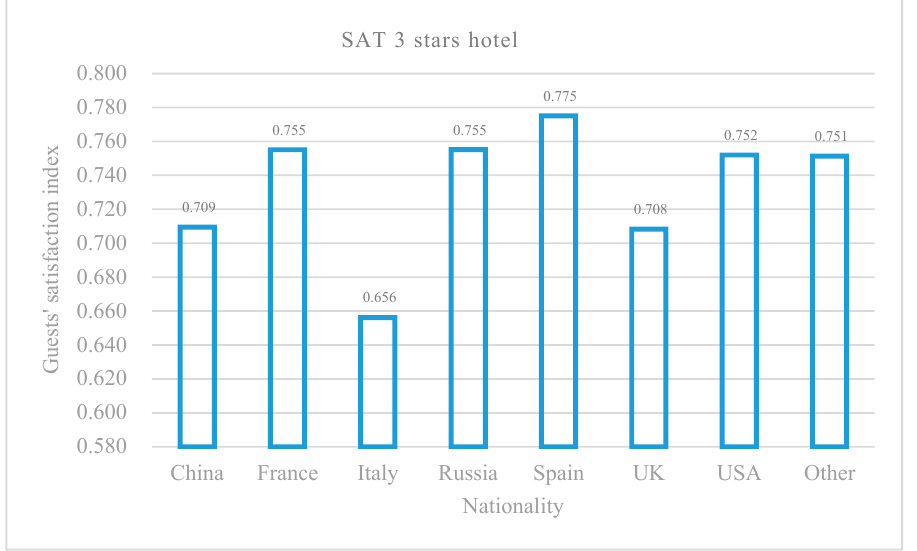
Figure 1. Guests’ satisfaction index by nationality in the three-star hotel.